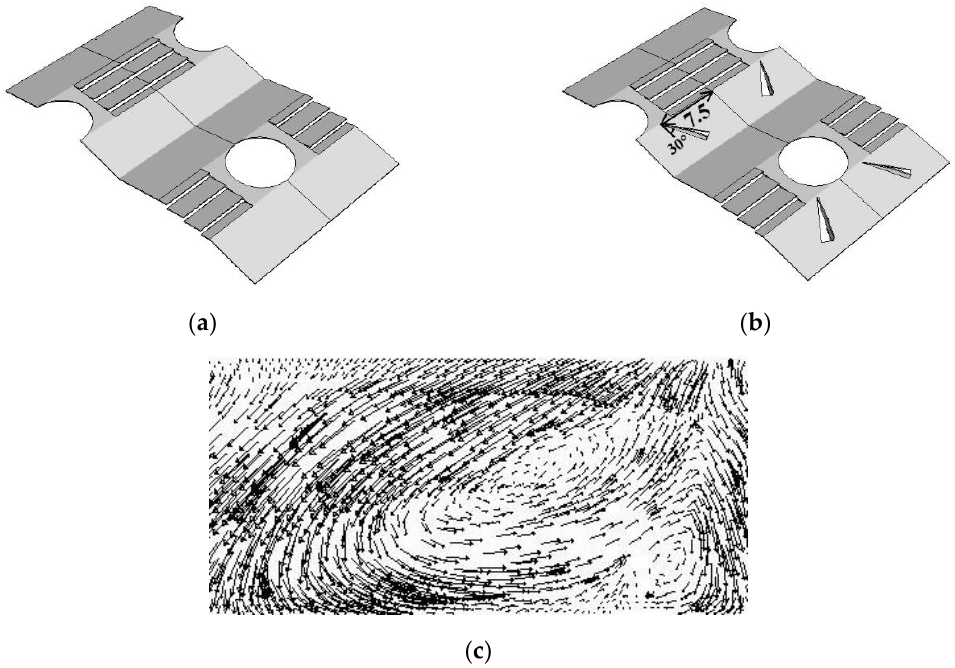
Figure 10. Compound geometries ( n = 3, W = 12 mm and θ = α = 13°): ( a ) Without vortex generators; ( b ) with vortex generators; ( c ) vortices generated by delta winglets.